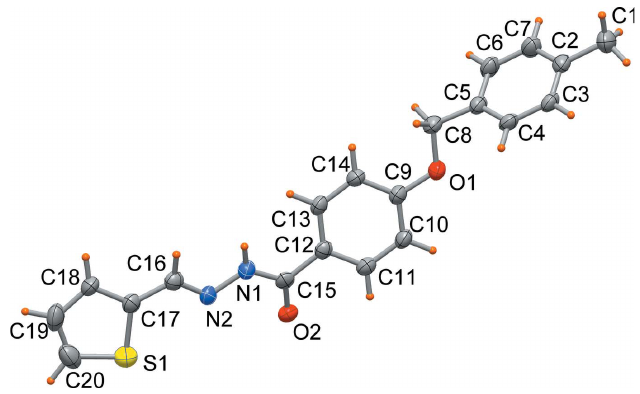
Figure 2 Molecular structure of (II), with displacement ellipsoids drawn at the 50% probability level.